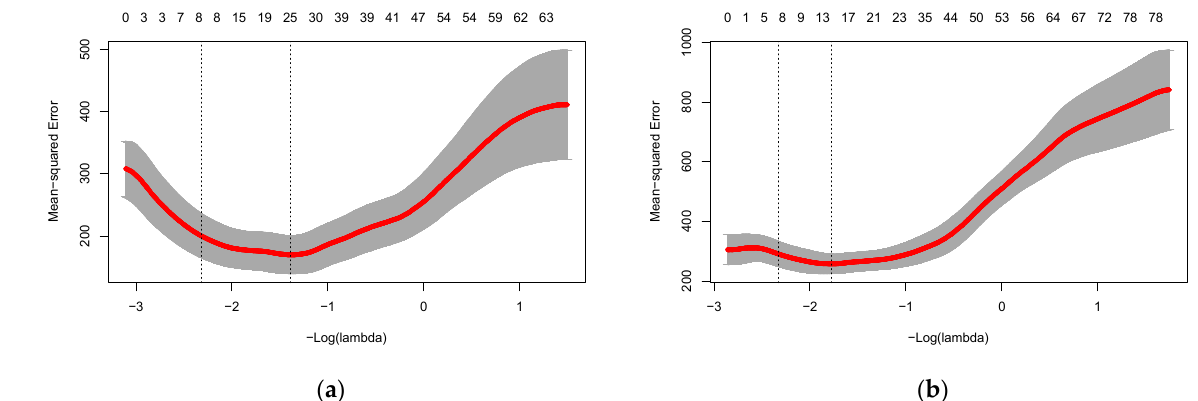
Figure 1. Visualization of the procedure used to train a model of participants’ age based on the acoustic parameters of the sustained vowel [a]. The regularization parameter lambda was selected so that the mean-squared error (MSE) was within one standard error (left dashed horizontal line) from the model with the smallest MSE. ( a ) The model of participating women’s ages; ( b ) The training of the model for men. The number of acoustic measures of [a] that were identified to primarily contribute to the prediction of speakers’ ages is indicated at the top of each subfigure.